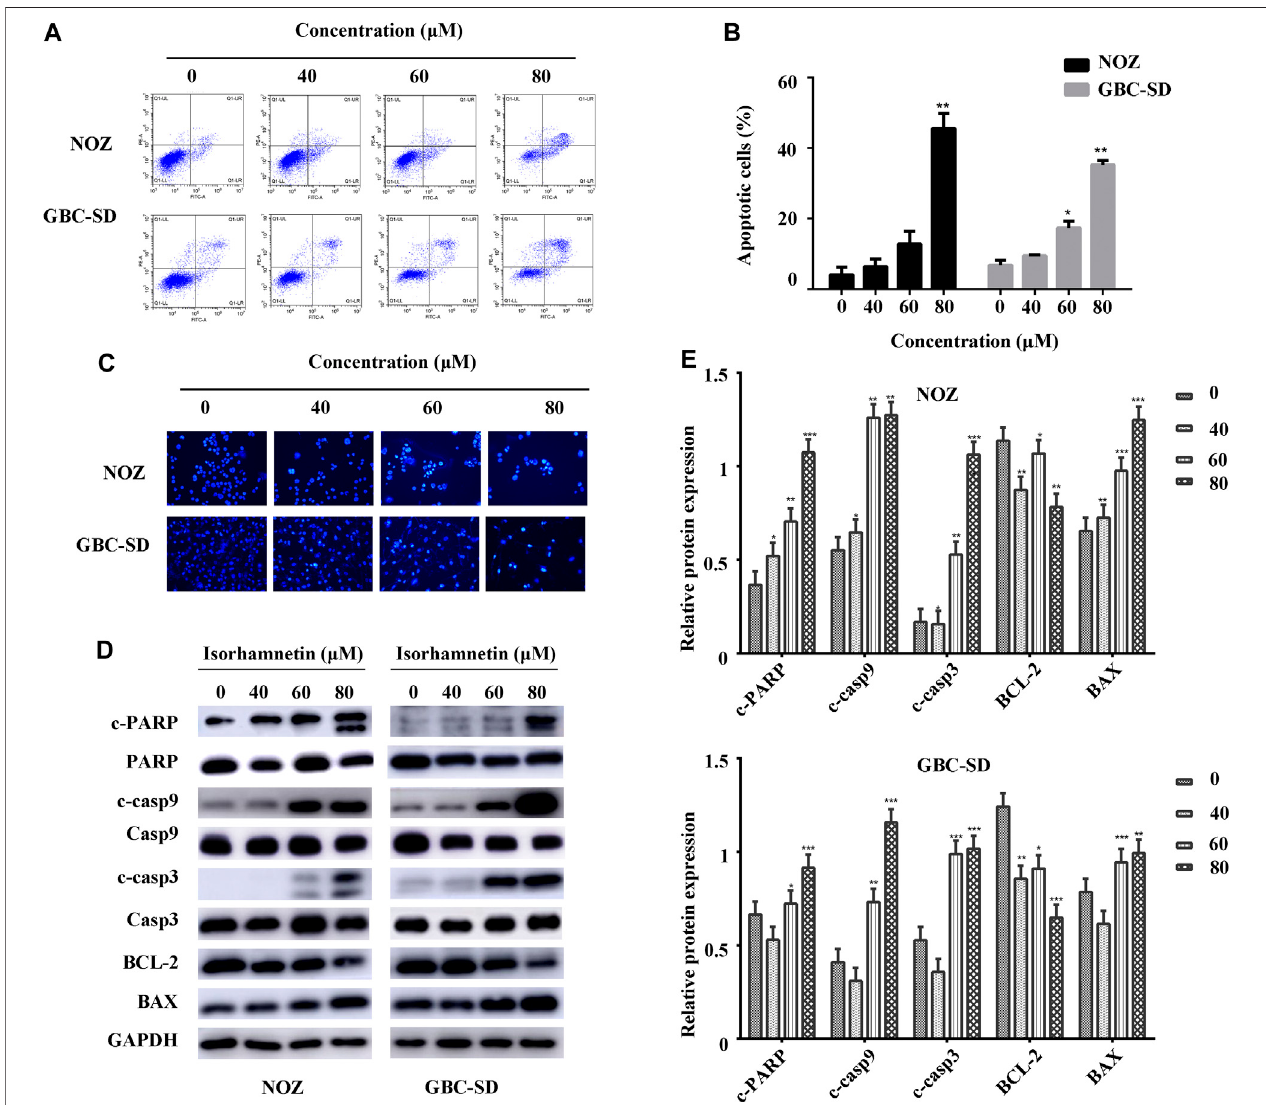
FIGURE 3 | Isorhamnetin induces GBC cell apoptosis. (A) The stained NOZ and GBC-SD cells exposed to isorhamnetin (0, 40, 60, and 80 μ M). (B) Apoptotic cell proportions are expressed as the mean ± SD. (C) The apoptotic nuclear morphology alterations were assessed using Hoechst 33342 staining via a fl uorescence microscope. (D) Theexpressionand (E) statisticresultsofcleavedPARP,PARP,BAX,cleavedcaspases9,caspases9,BCL-2,cleavedcaspases3,andcaspases3in NOZ and GBC-SD after isorhamnetin treatment. * p < 0.05, ** p < 0.01 relative to the control